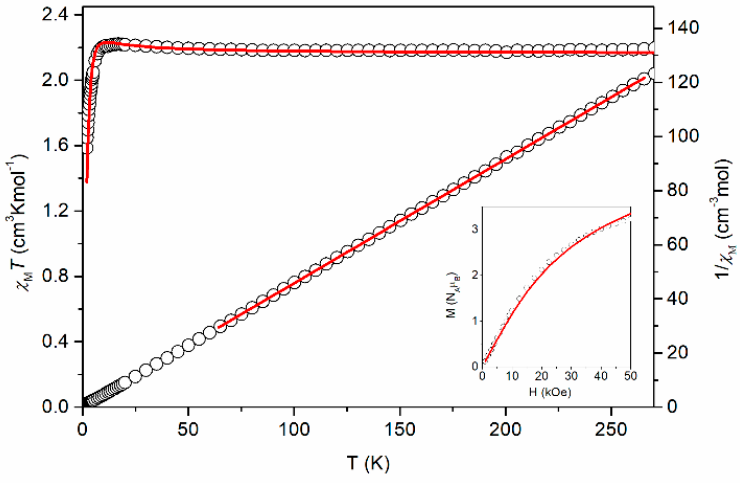
Figure 10. Plots of χ M T vs. T and 1/ χ M vs. T at 1000 Oe and M vs. H at 2.2 K (inset) for 3 . Solid lines represent the best fit obtained with the magnetic model described in the text.